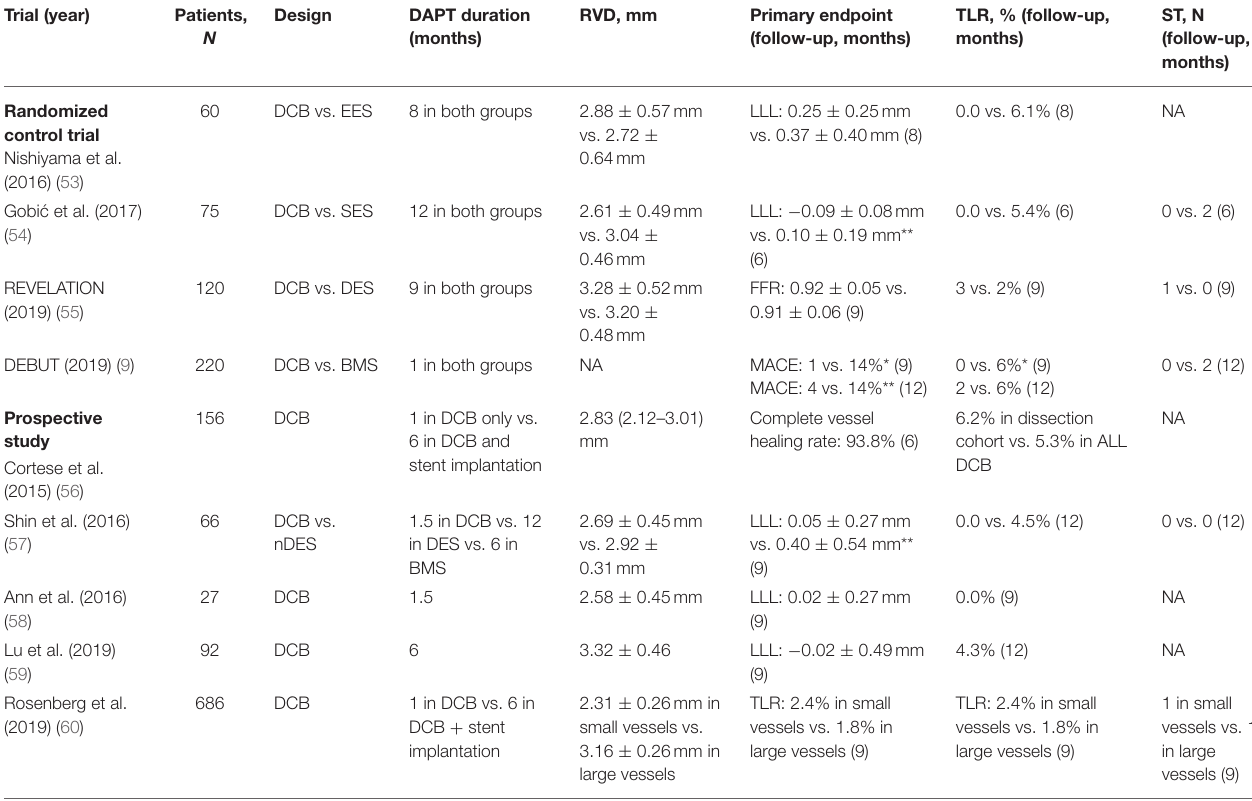
DAPT, dual anti-platelet therapy; RVD, reference vessel diameter; TLR, target lesion revascularization; ST, stent thrombosis including definite and possible; DCB, drug-coated balloon; EES, everolimus-eluting stent; LLL, late lumen loss; DES, drug-eluting stent; FFR, fractional flow reserve; SES, sirolimus-eluting stent; BMS, bare-metal stent; MACE, major adverse cardiac events. * P < 0.01 vs. non-DCB